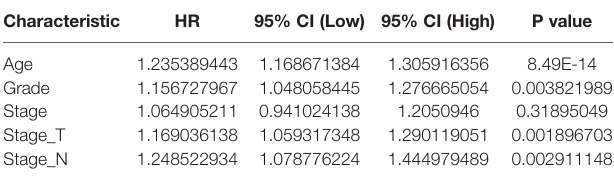
TABLE 3 | Multivariate Cox regression analysis of the relationship between clinicopathological features and prognosis in gastroesophageal junction carcinoma